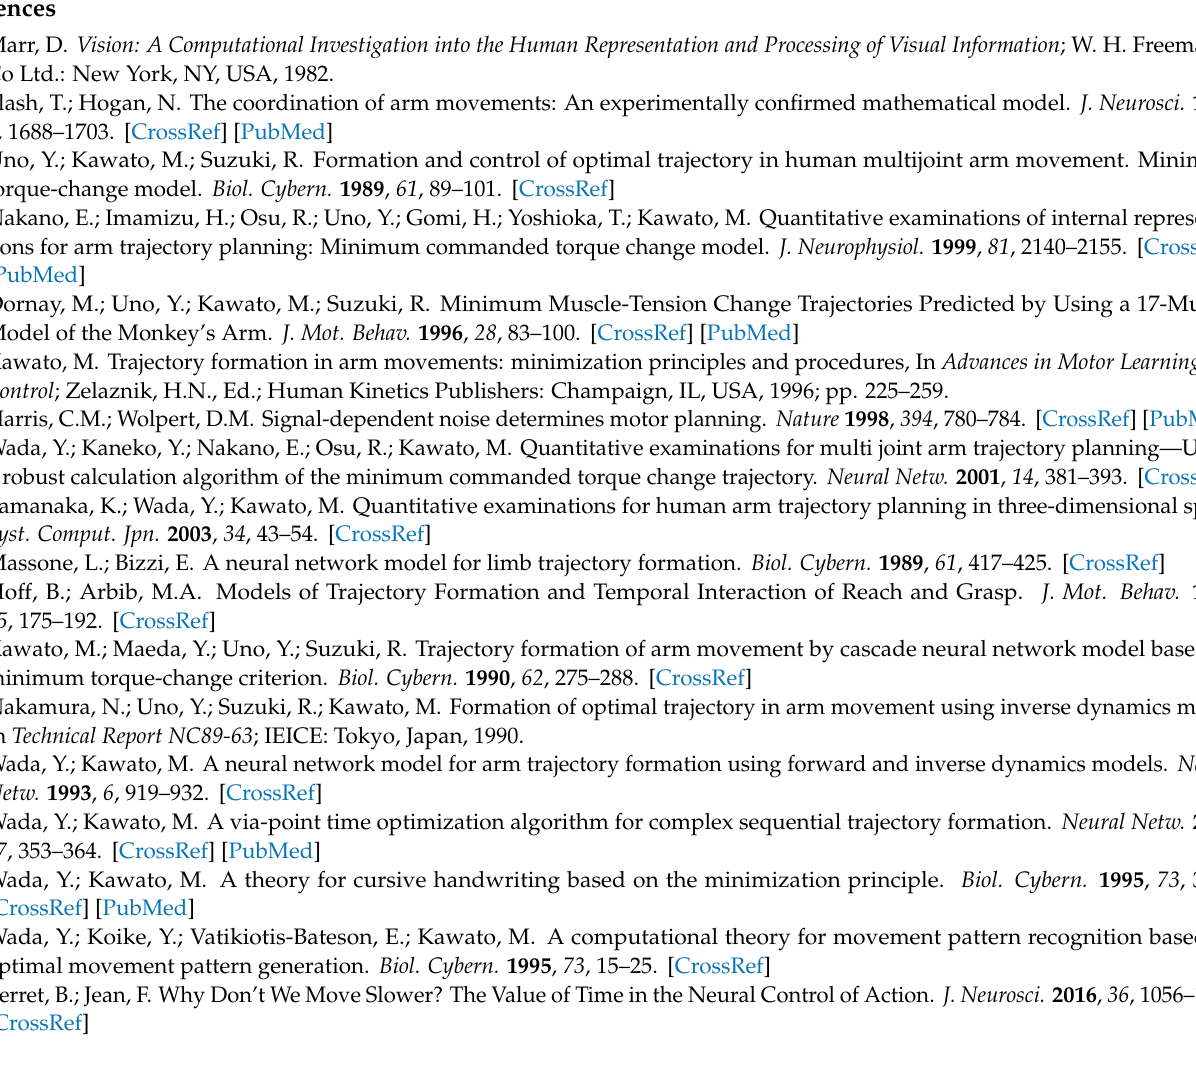
Figure S5: Subject F (Movement